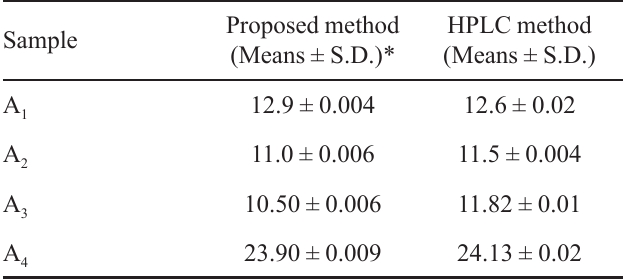
TABLE II - Results from rosuvastatin quantification by the developed methodology (UV-vis) and the reference